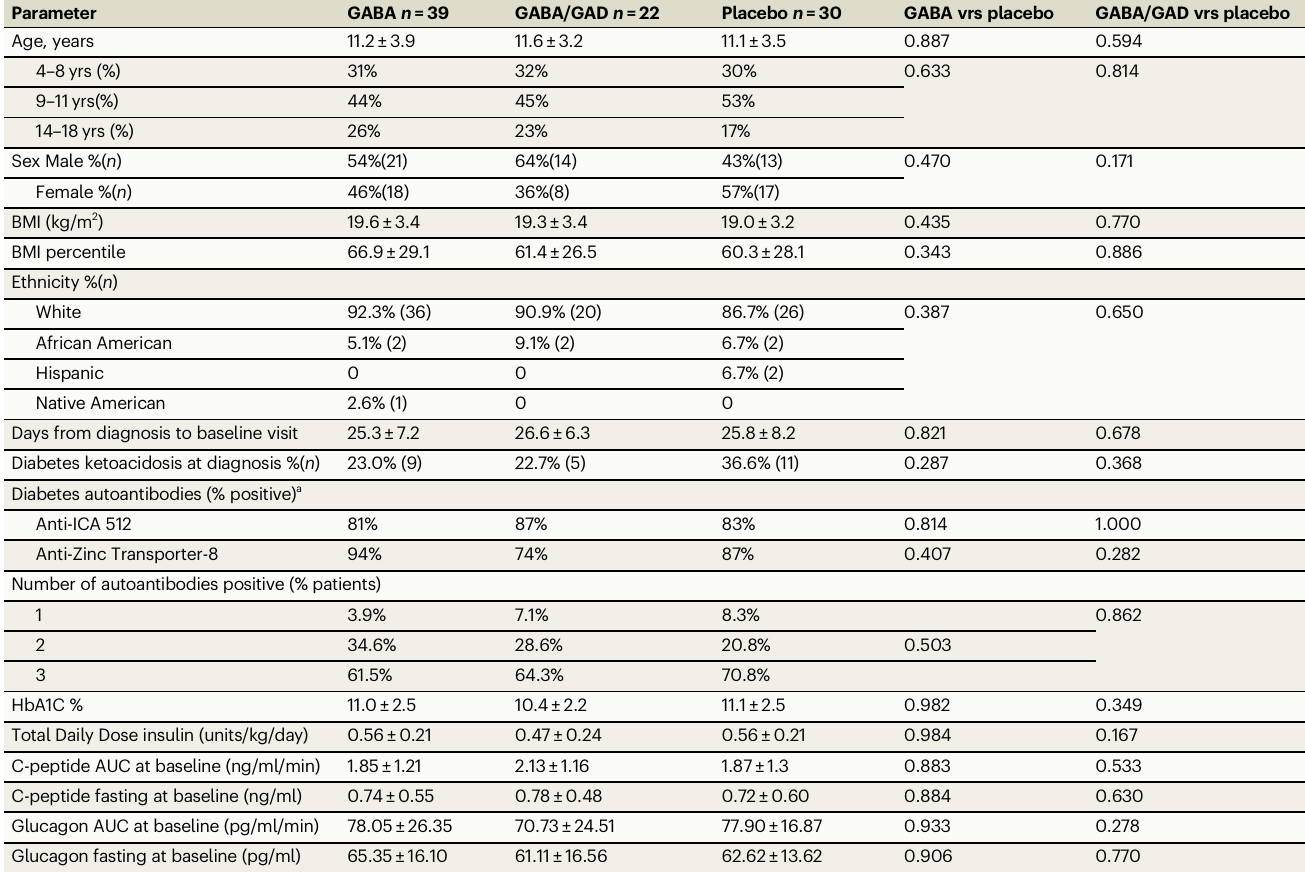
Table 1 | Baseline participant